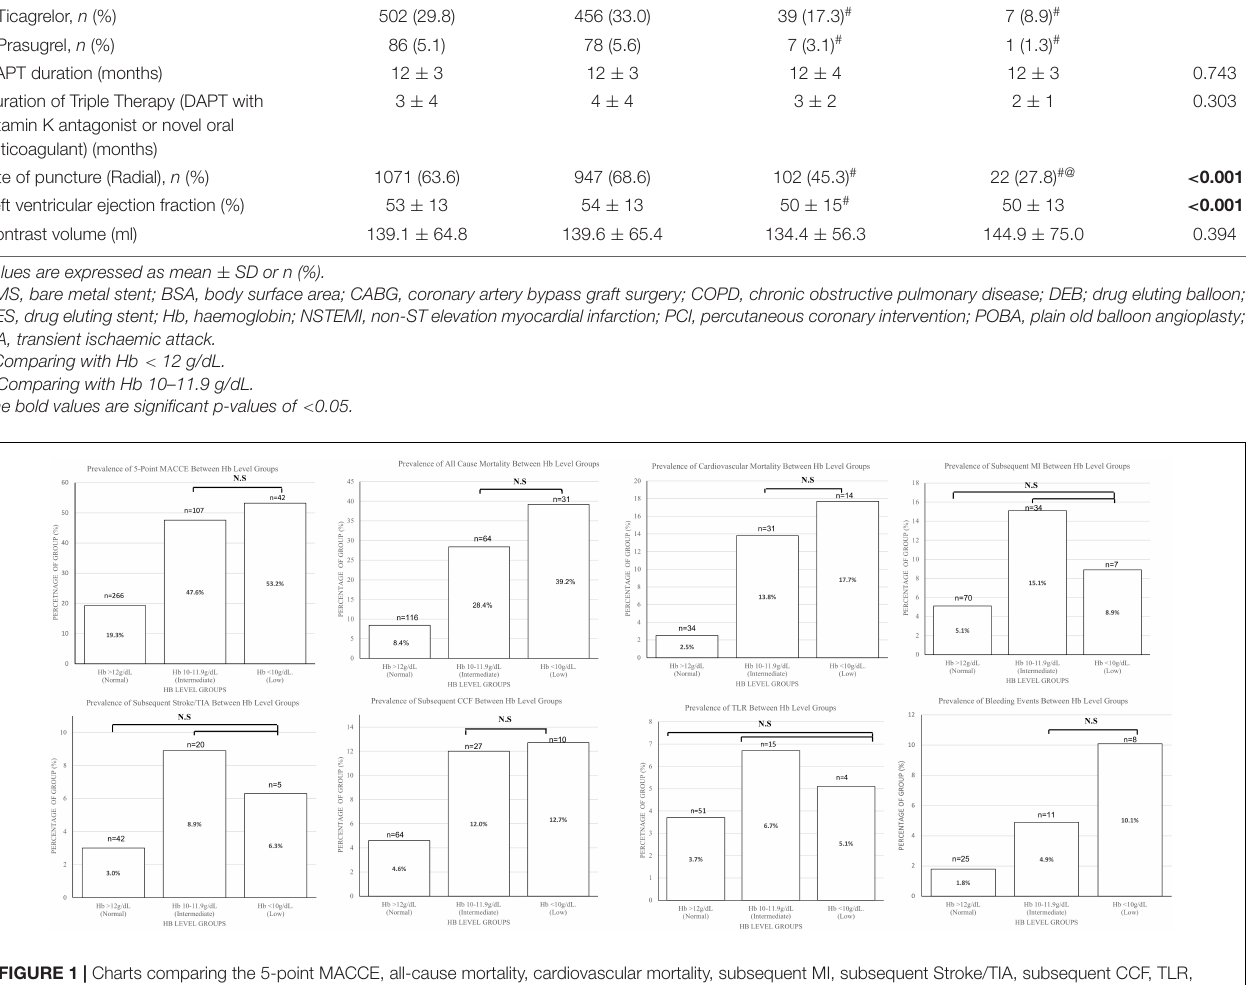
FIGURE 1 | Charts comparing the 5-point MACCE, all-cause mortality, cardiovascular mortality, subsequent MI, subsequent Stroke/TIA, subsequent CCF, TLR, bleeding Events, and ≥ BARC3 between haemoglobin level groups. Bar chart height shows the number of patients, while numbers in the bar charts show the percentage of patients that met the endpoint in each group. Comparisons between all groups are significant with p < 0.001 except for those stated as non-significant. BARC, bleeding academic research consortium; CCF, congestive cardiac failure; Hb, haemoglobin; MACCE, major adverse cardiac